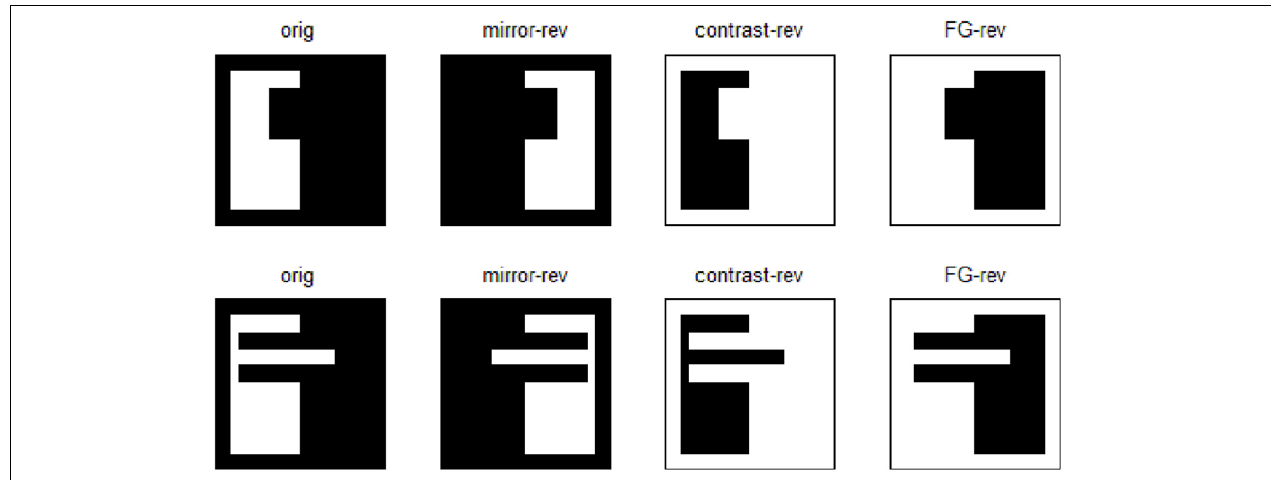
FIGURE 2 | Chosen images and their mirror-reversals, contrast-reversals, and figure-ground reversals. Note that within each row, the total length of the existing borders for every image is the